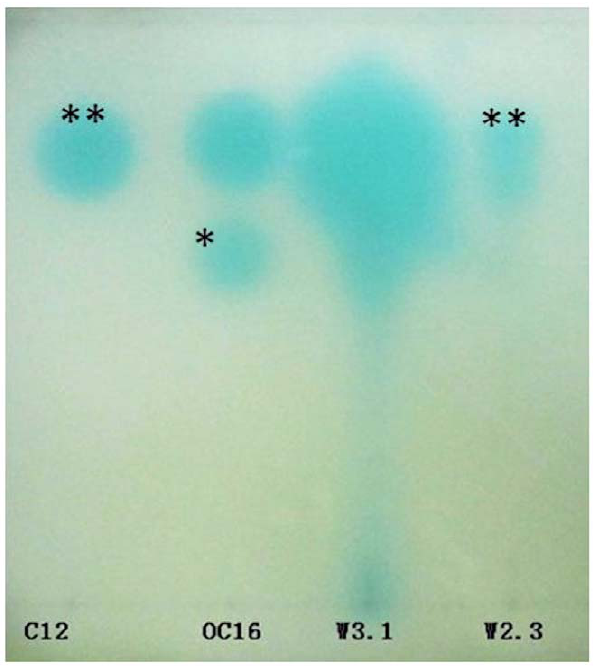
Figure 4. Thin layer chromatography analysis of AHLs. AHL standards from Sigma (C12-HSL (**) and 3-oxo-C16-HSL (*)) and 10 m l of W3.1 and W2.3 extract were spotted on normal phase TLC plate. The TLC plate was chromatographed with dichloromethane and methanol as mobile phases. The locations of AHLs were revealed by overlay of Agrobacterium tumefaciens NTL4 pZLR4 as evident by blue pigmenta- tion. Based on the R f values, W2.3 produced C12-HSL.